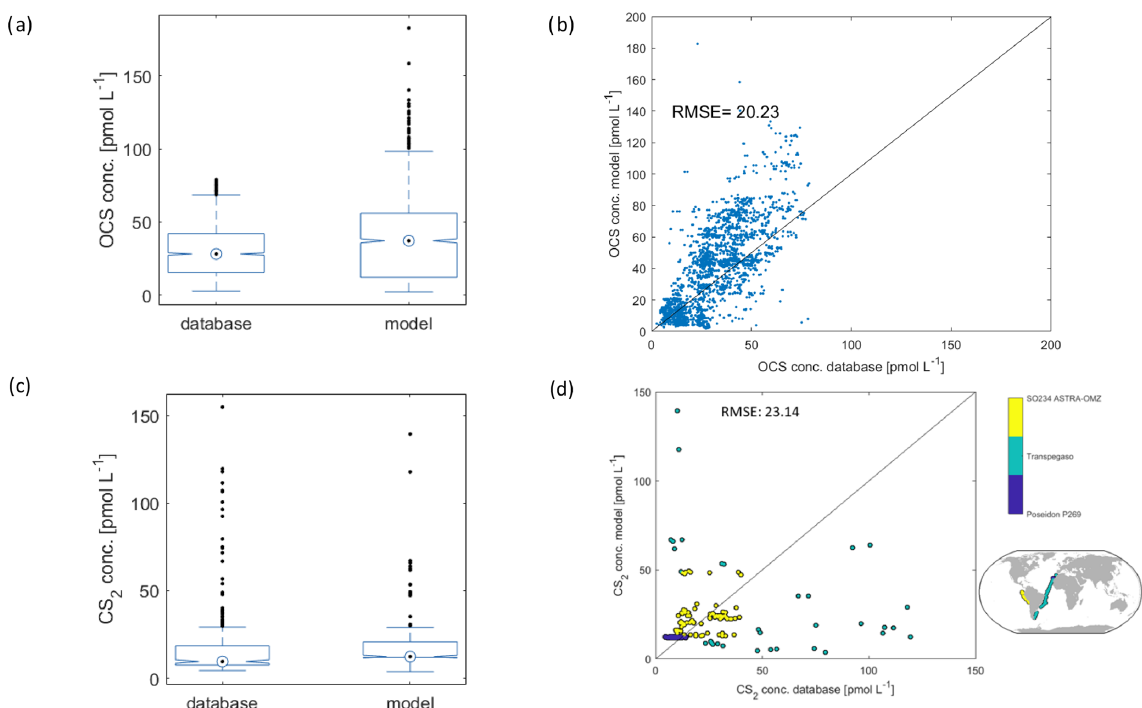
Figure 7. Comparison of model output to observations from the database described in Lennartz et al. (2020). (a) Box plot of OCS reference data from database and subsampled model output at the time and location of measurements (32 cruises), (b) scatter plot of 1:1 comparison with the same data as in (a) . The black line is the 1:1 line, and (c) and (d) are the same as (a) and (b) but for CS 2 (three